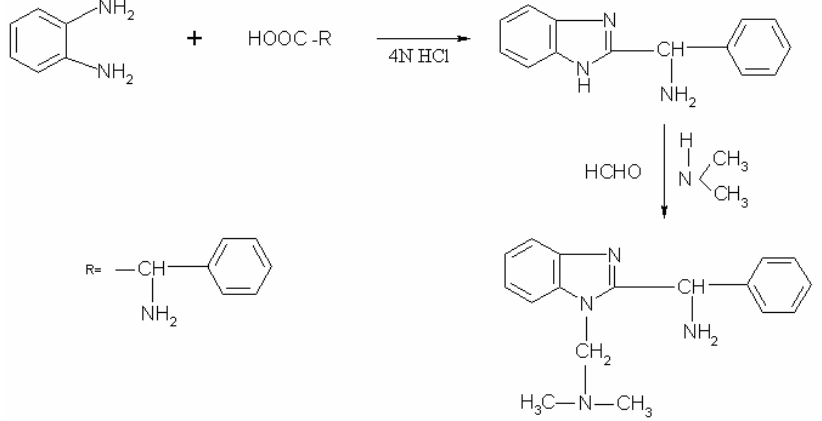
Figure 2. Preparation of benzimidazole using Mannich